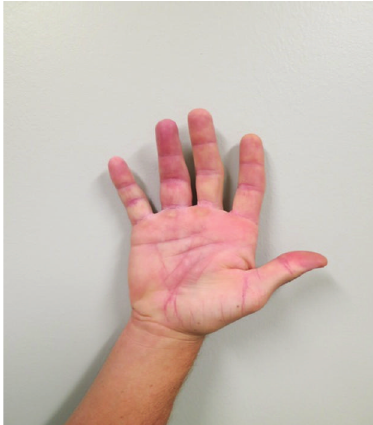
Figure 1: Initial presentation of injury. Three weeks after a barb fish spine penetrated the volar aspect of the proximal portion of his ring finger on his right hand. The injury occurred while fishing along one of the Charleston charters in August. He complained of a gradual increase in pain and swelling of the finger. On physical examination, entry and exit points were noted on the affected finger. Marked swelling was present; however, no bruising, cellulitis, discharge, erythema, or induration was noted. He was able to extend and flex the finger.